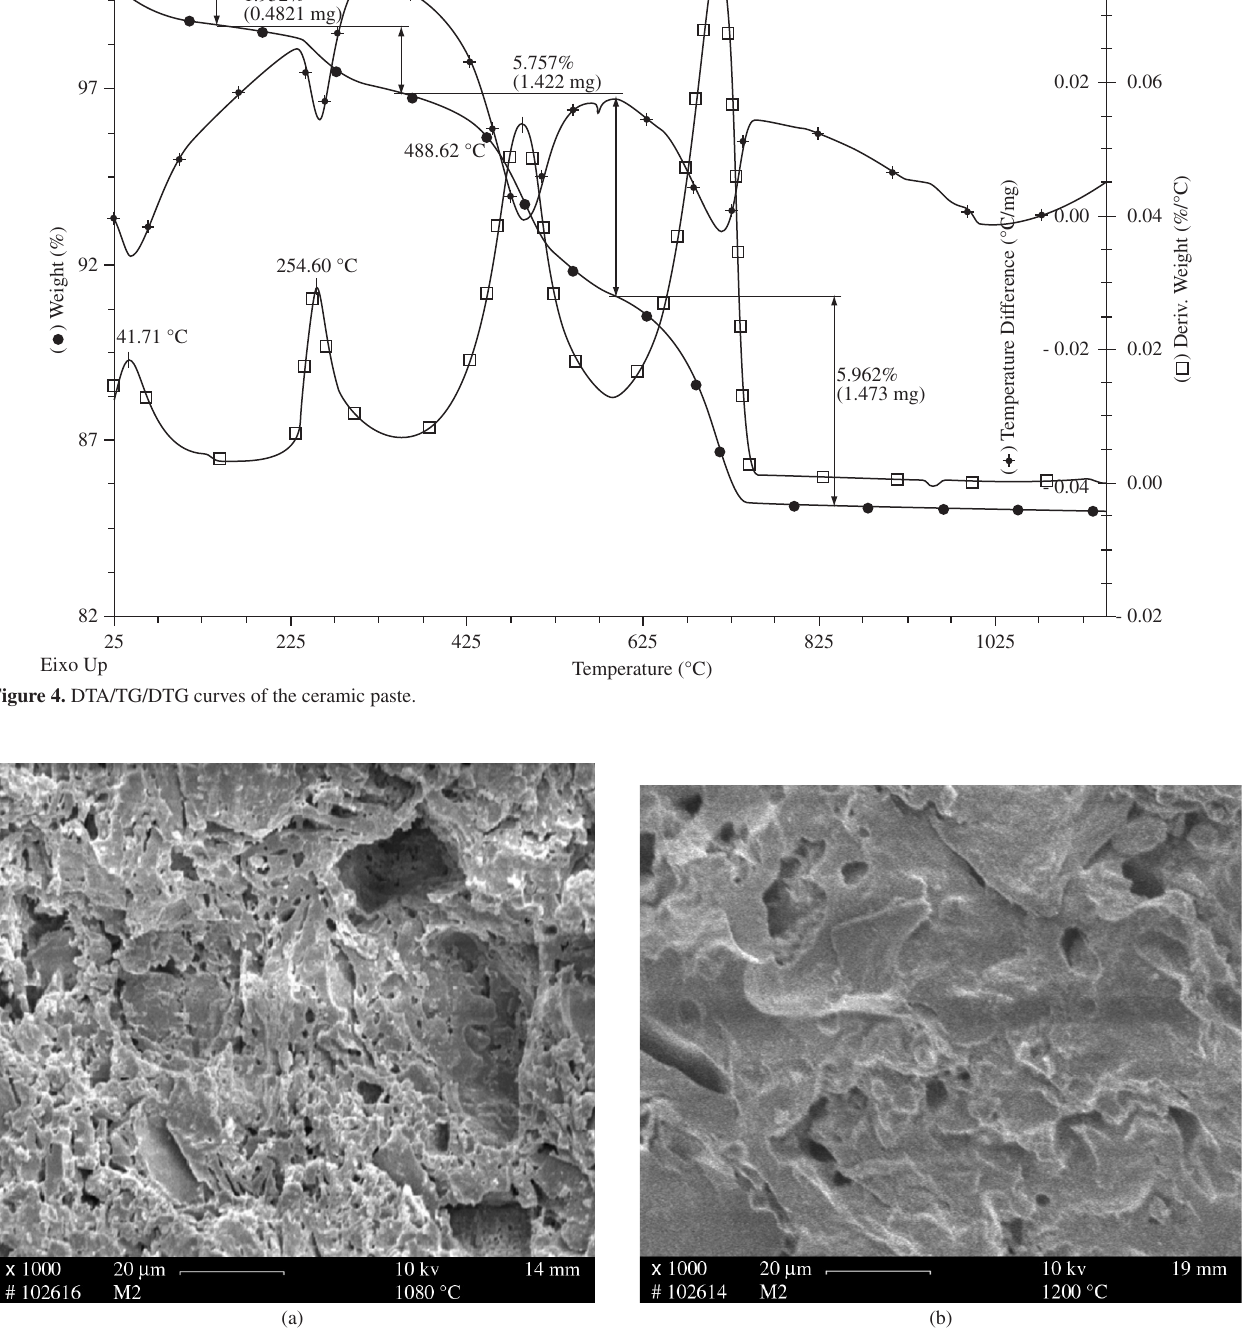
Figure 5. Fractured surface of the ceramic bodies sintered: a) 1080 °C; b) 1200